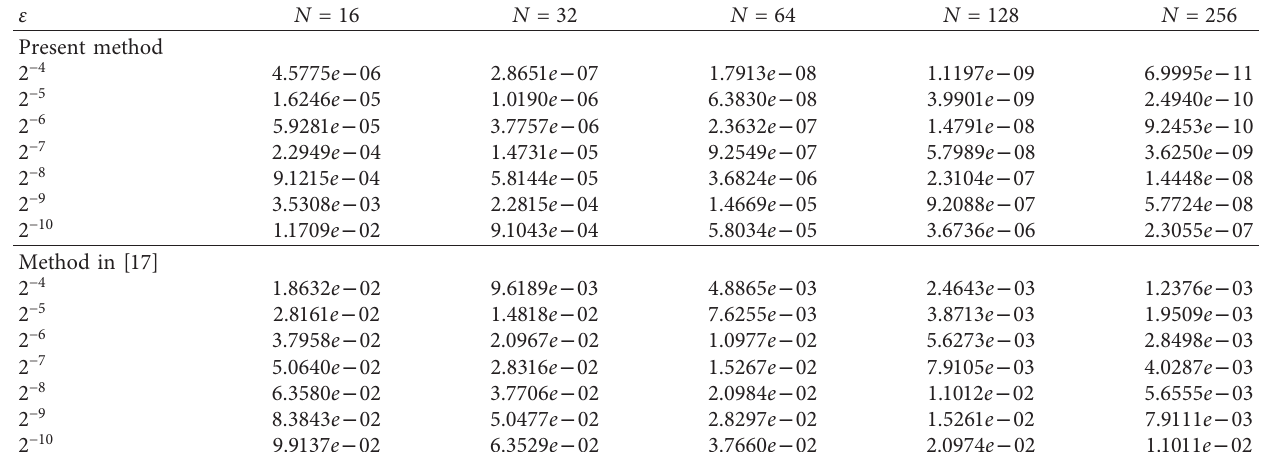
Table 2: The maximum absolute errors of Example 1 for different values of ε with δ � 0 . 5 ε .